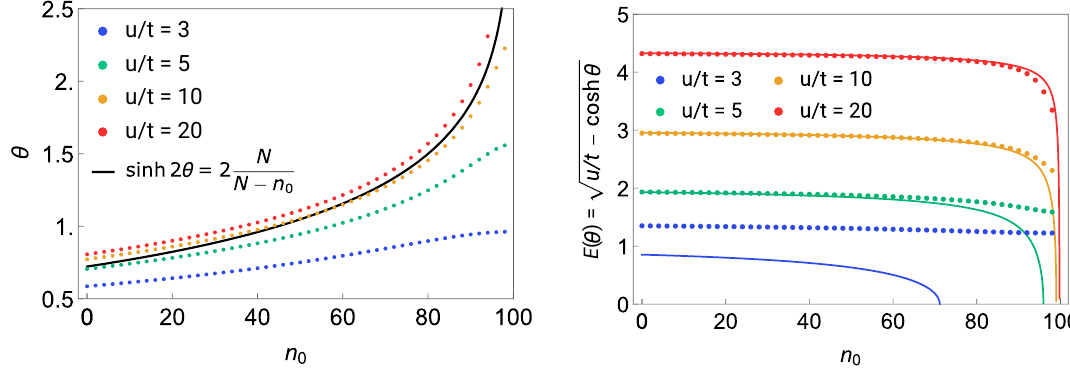
Figure 2 . In the left panel, a plot of the values of ϑ as a function of the filling n 0 . Here, g = 1 and we have chosen N = 100 and varied u . Also plotted in black is the approximation sinh 2 ϑ ≈ 2 N which is a valid in a regime where u is large compared to cosh θ but small compared to N 2 . We even see good accuracy of the approximation beyond the regime of validity. In the right panel, a plot of the bound state energy as a function of the filling n bound state energies obtained from the